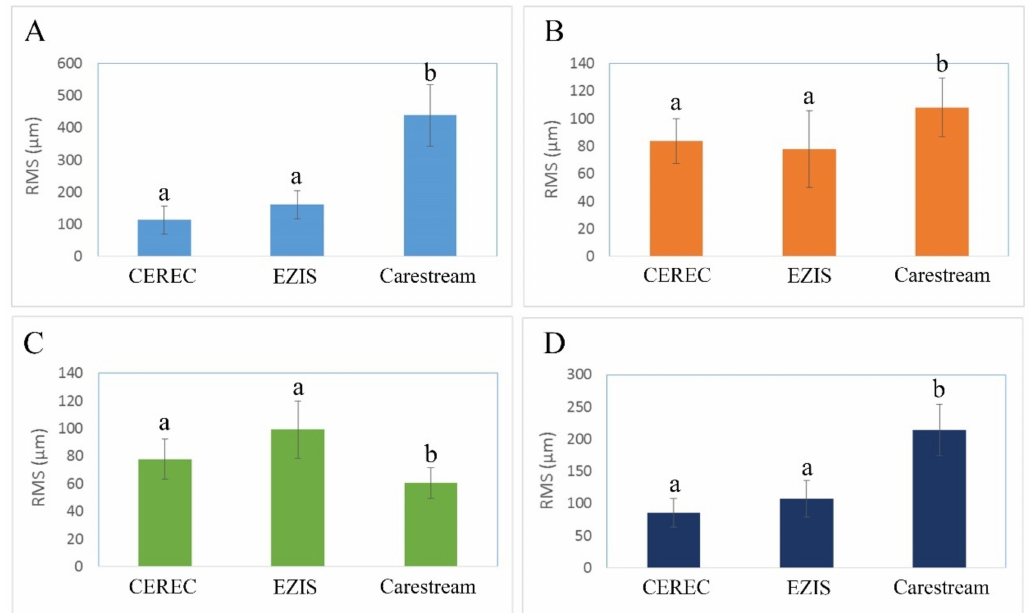
Figure 6. Marginal and internal fit comparisons within each measurement region. ( A ) Occlusal gap; ( B ) axial gap: ( C ) marginal gap; ( D ) whole gap. Values with the same letter (a, b) are not statistically different based on a pairwise comparison test ( p < 0.05).